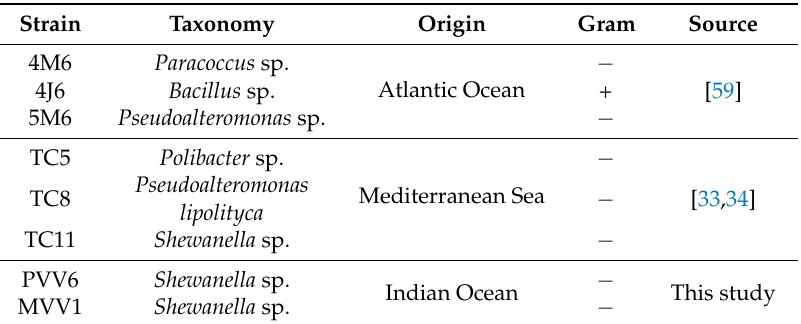
Table 5. Bacterial strains used in the